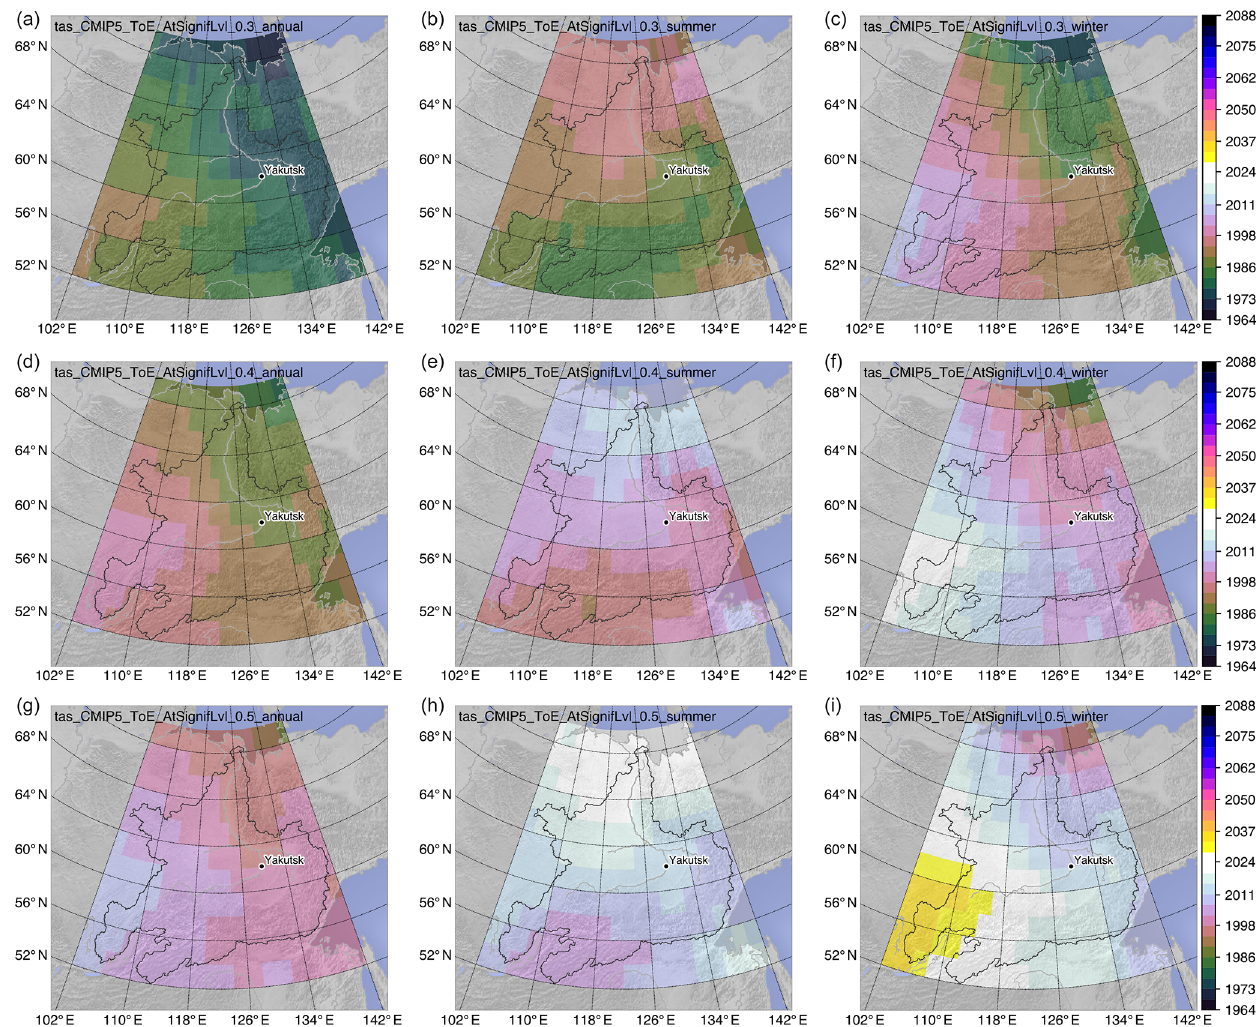
Figure 8. Time of emergence for temperature (tas) according to 30% (a–c) , 40% (d–f) , and 50% (g–i) emergence for annual (a, d, g) , summer (b, e, h) , and winter (c, f, i) values. Values are the mean over all individually determined ToE values for each of the 65 climate